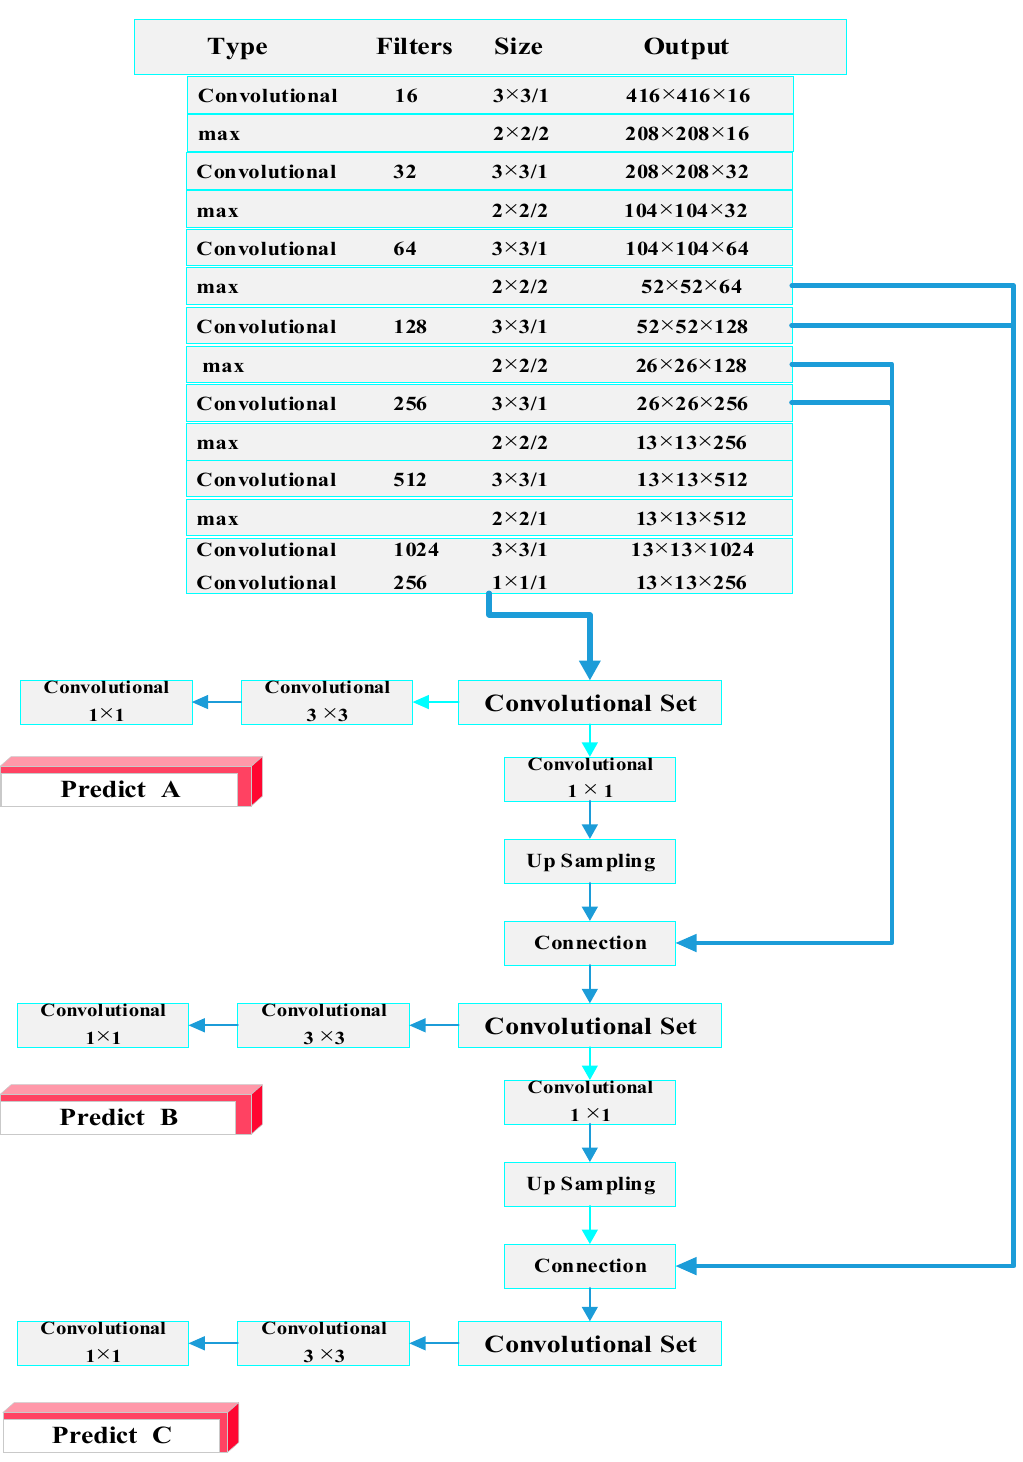
Figure 3. Workflow of the proposed TF-YOLO network.